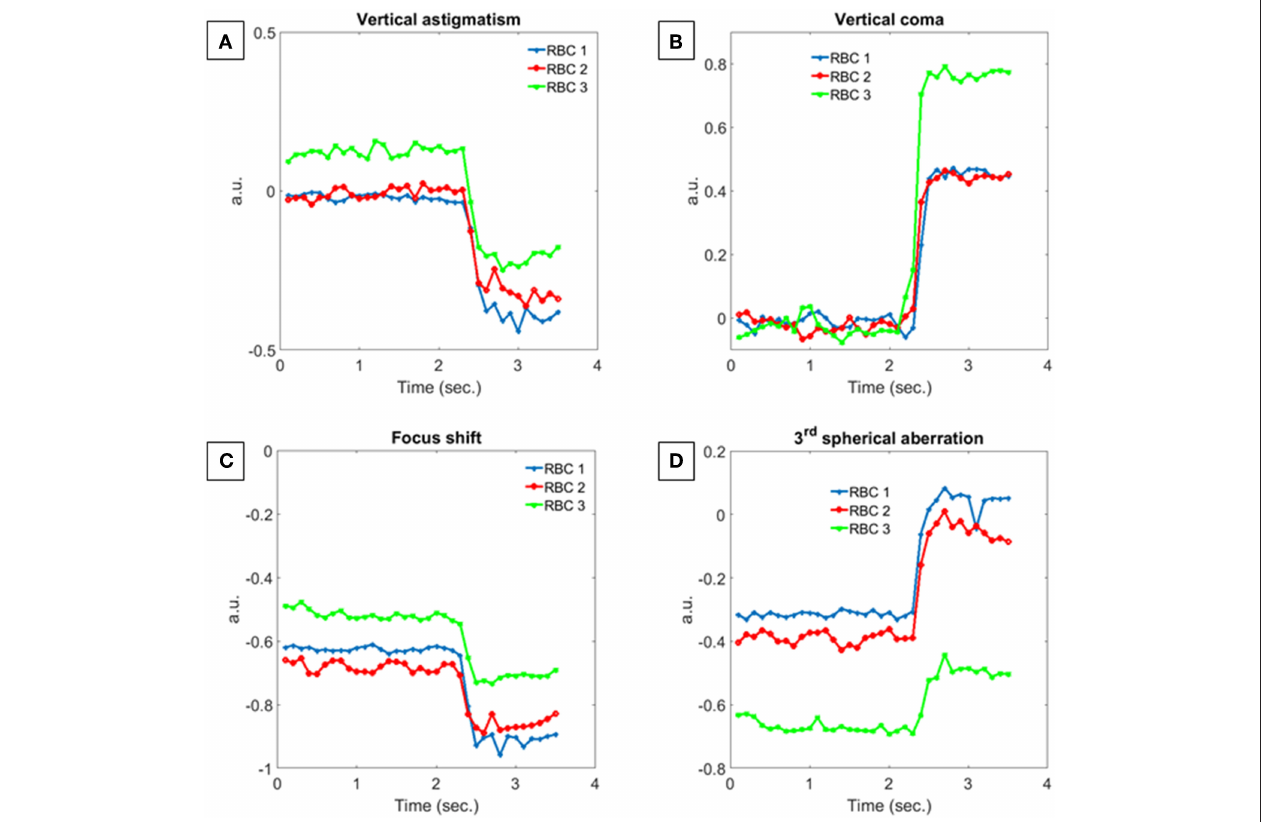
FIGURE 6 | Normalized Zernike coefficients trend calculated for RBC 1, RBC 2 and RBC 3. (A) Vertical astigmatism, (B) vertical coma, (C) focus shift, and (D) third order spherical aberration.